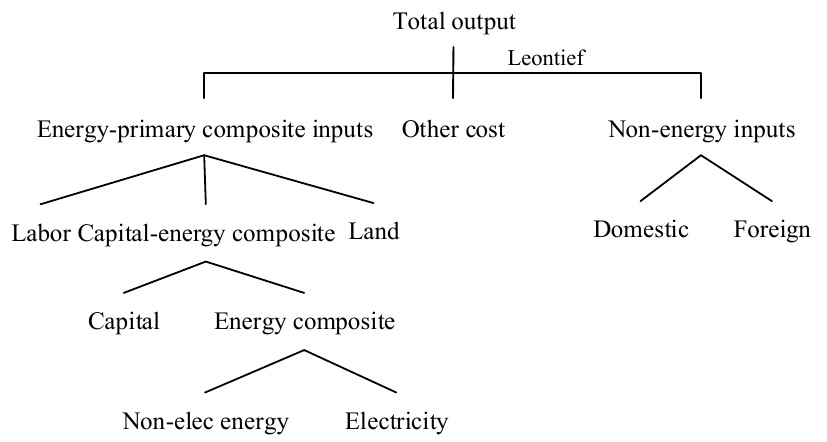
Figure 2. The nesting structure of the producing input used by sectors.